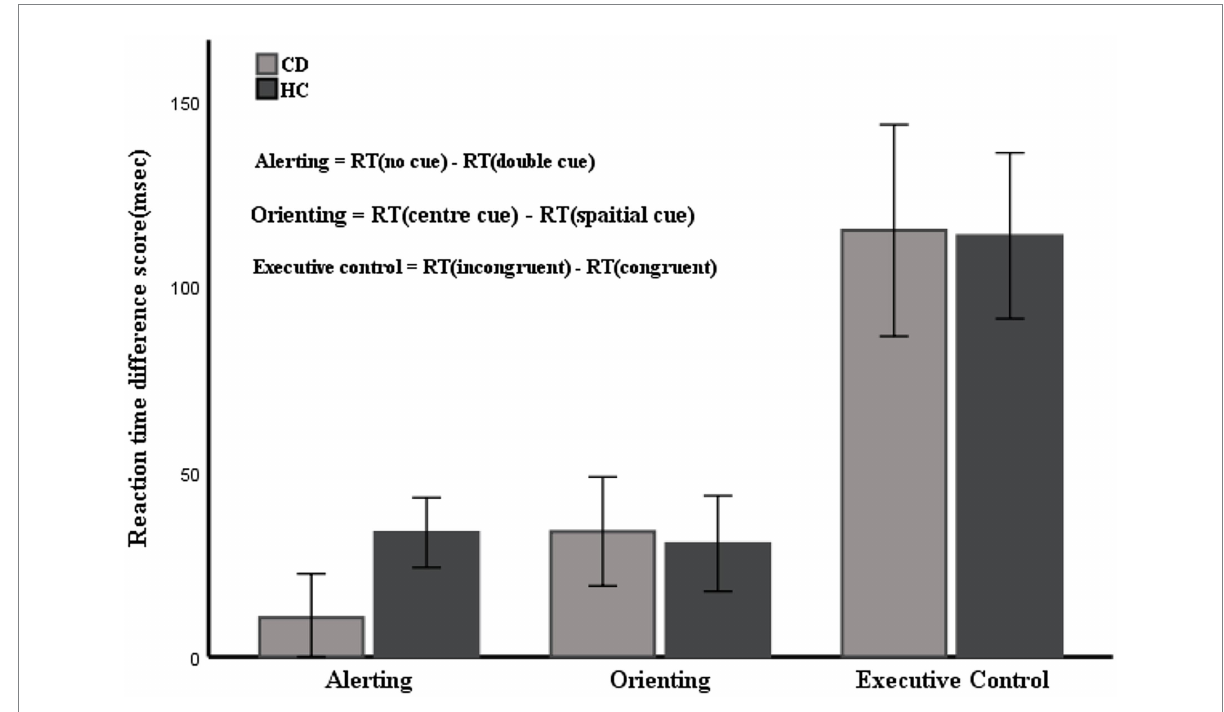
FIGURE 4 Mean RTs of the alerting, orienting, and executive network. Error bars represent mean standard